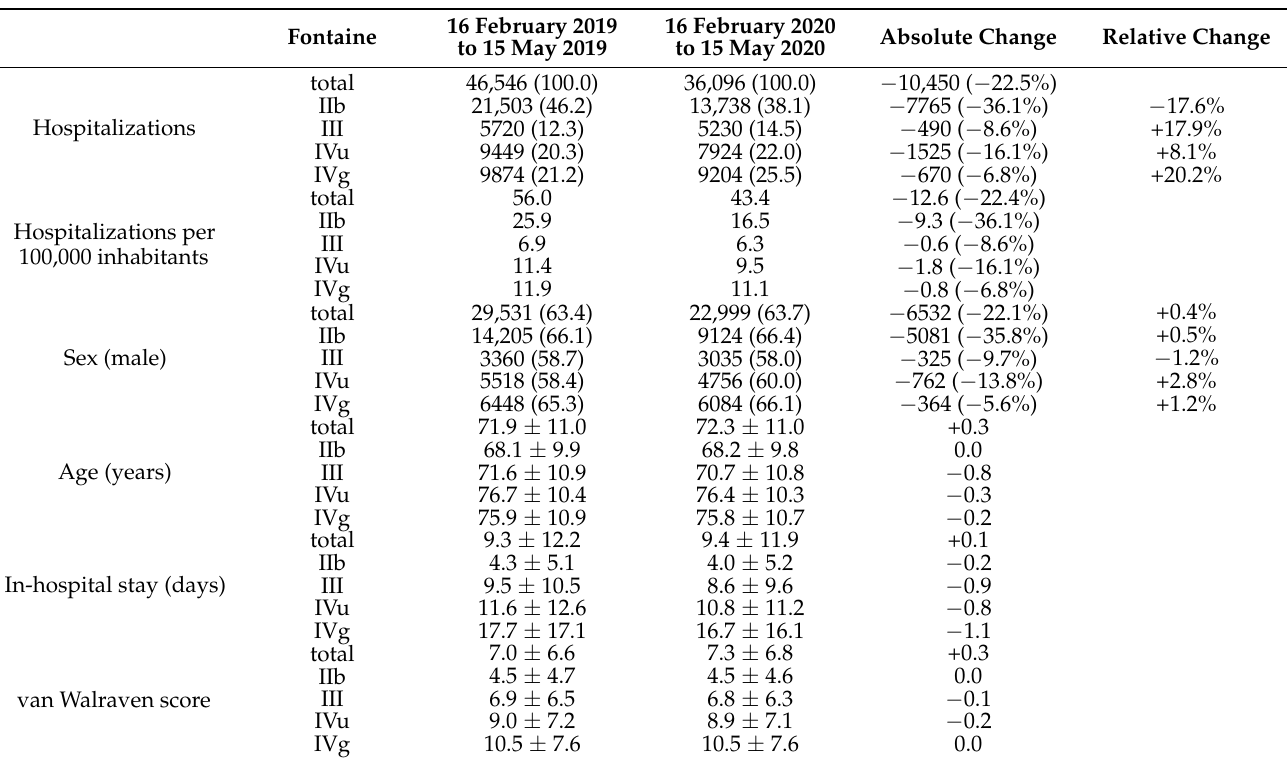
Table 2. Baseline characteristics of patients hospitalized due to peripheral artery disease from